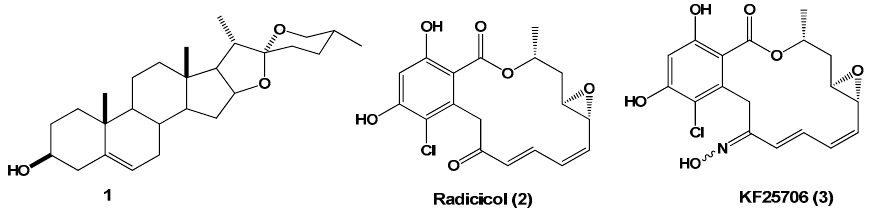
Figure 1. Diosgenin ( 1 ); radicicol ( 2 ); and radicicol oxime derivative ( 3 ).